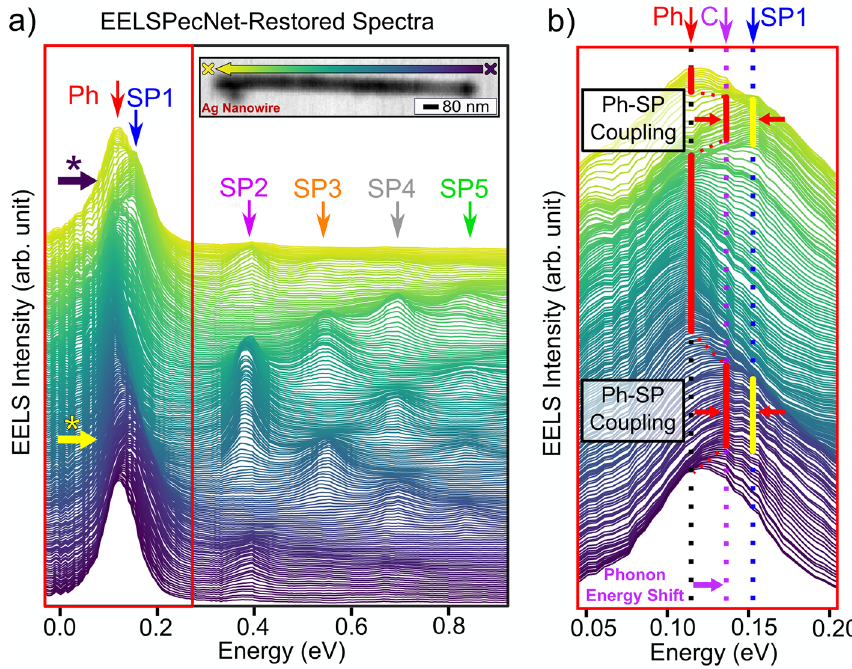
Figure 8. ( a ) EELSpecNet-restored NZ-EELS spectra extracted from along the silver nanowire, as is shown in the BF-STEM image on the top-right. ( b ) Magnified spectra around the 0.1 eV (as is shown in the red box in ( a )). SiN phonon excitation, first surface plasmon mode in silver, and the shifted (coupled) energy state of the SiN phonon excitation are respectively shown by “Ph”, “SP1”, and “C”